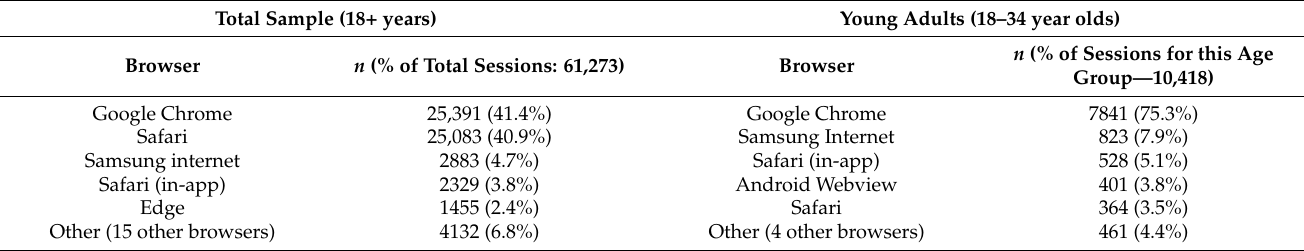
Table 7. Proportion of total sessions by internet browser used to access No Money No Time. Total Sample (18+ years)